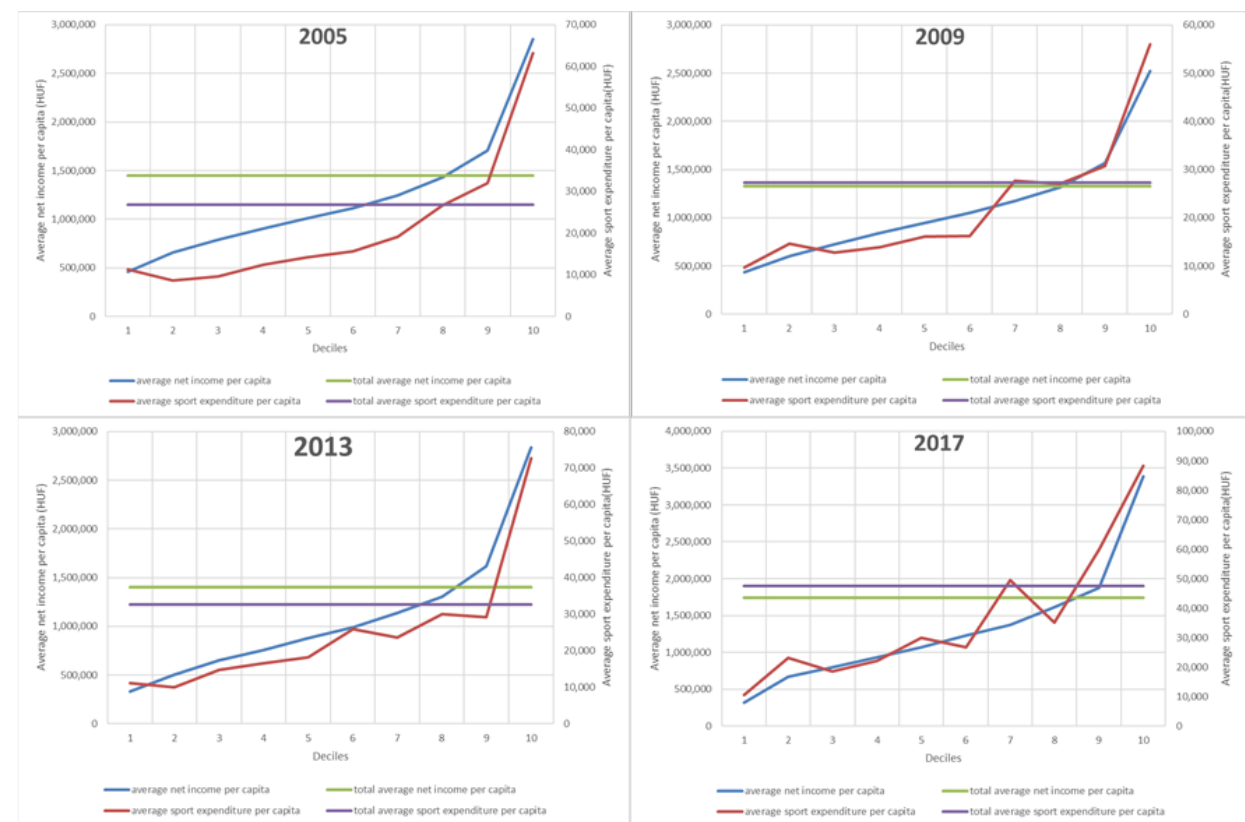
Figure A1. Average net income per capita and sports expenditure per decile in the sub-sample of people with sports expenditures (HUF). Source: own calculation.